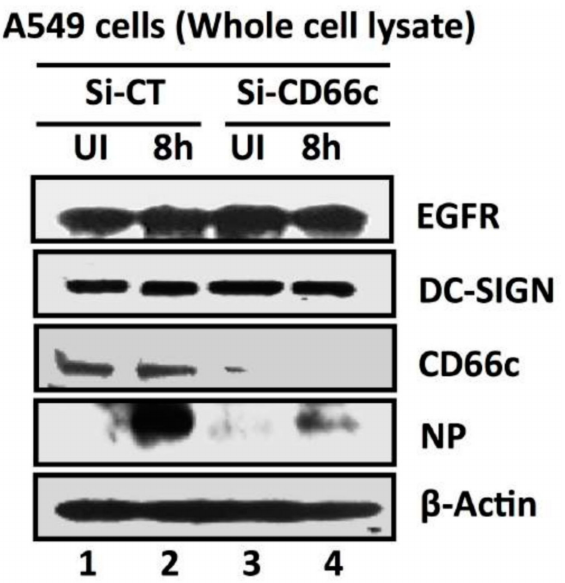
Figure 5. siRNA-mediated knockdown of CD66c shows inhibition of virus entry into lung-cells infected with 1 MOI of PR8 virus, through western blot analysis. Here, Si-CT denotes control siRNA treated cells; Si-CD66c are cells treated with CD66c siRNA. 8h are cells harvested after 8 h of infection (one life cycle of IAV), UI are uninfected cells. A549 cells treated with siRNA show complete knock down of the receptor molecule CD66c (third panel from top) while control siRNA treated cells do not show any reduction in expression of CD66c (left two wells of third panel). The fourth panel from top shows level of A/PR8/34 influenza virus entry in cells determined by expression levels of viral NP protein. The second well from left shows significant expression level of viral NP protein in cells treated with control siRNA, eight hours after infection. In contrast, the right-most well shows a marked reduction of influenza A virus (IAV) entry in cells treated with CD66c siRNA, as determined by low expression level of viral protein NP eight hours after infection. Conclusively, virus entry was inhibited in absence of CD66c (CD66c siRNA treated cells). CD66c siRNA treated cells do not show any noticeable change in expression levels of EGRF (topmost panel) and DC-SIGN (second panel from top). For loading control β -Actin was probed (the bottom